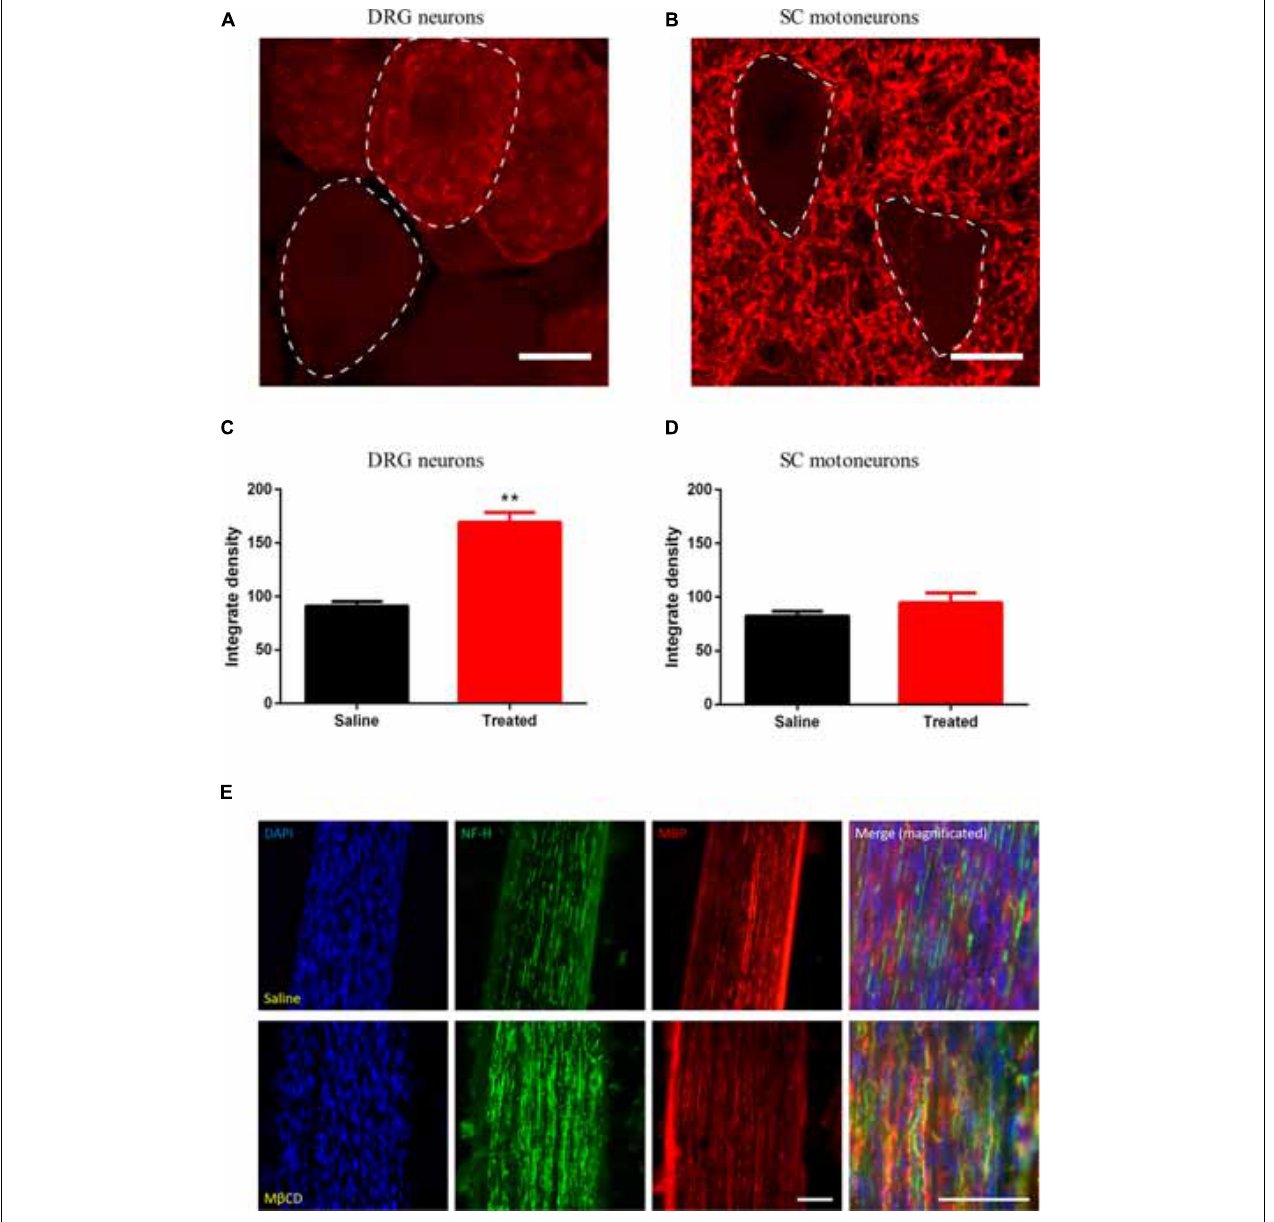
FIGURE 8 | M β CD increases GAP43 expression in injured DRG neurons. (A,B) Detail of DRG ( A , dashed line) and motoneurons ( B , dashed line) analyzed for GAP43 expression. (C,D) Quantification of GAP43 positivity in DRG neurons (C) and motoneurons (D) from animals treated with vehicle or M β CD vs. Saline. (E) Detail of a regenerated nerve stained for cell nuclei (blue), NF-H (green), and GAP43 (red) of saline- (top) and M β CD-treated (bottom) animals. Scale bar: 15 µ m in (A,B) ; 50 µ m in (E) . Student’s t -test, ∗∗ p <